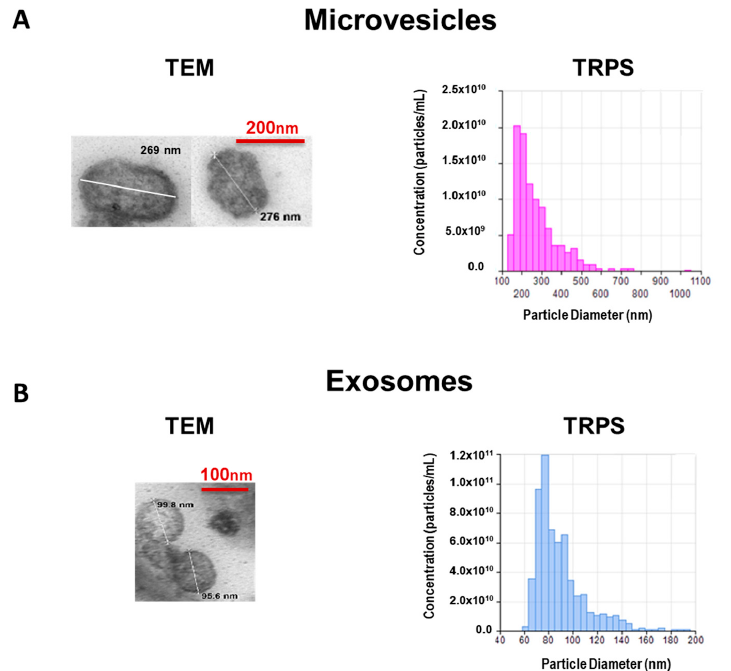
Figure 1. Characterization of microvesicles ( A ) and exosomes ( B ) isolated from CM of AMSC. Representative transmission electron microscopy (TEM) images with estimated size. Microparticle size distribution and concentration were determined by tunable resistive pulse sensing (TRPS).